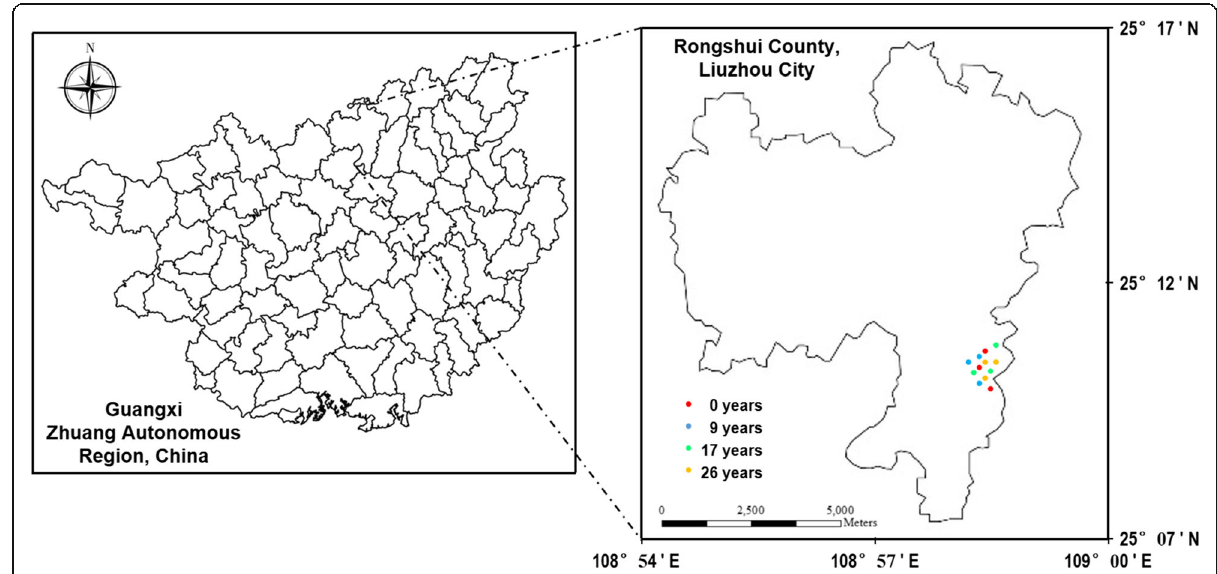
Table 1 Litter and soil properties in the Chinese fir plantations with different stand ages (0 years, 9, 17, and 26 years old) Sample Item